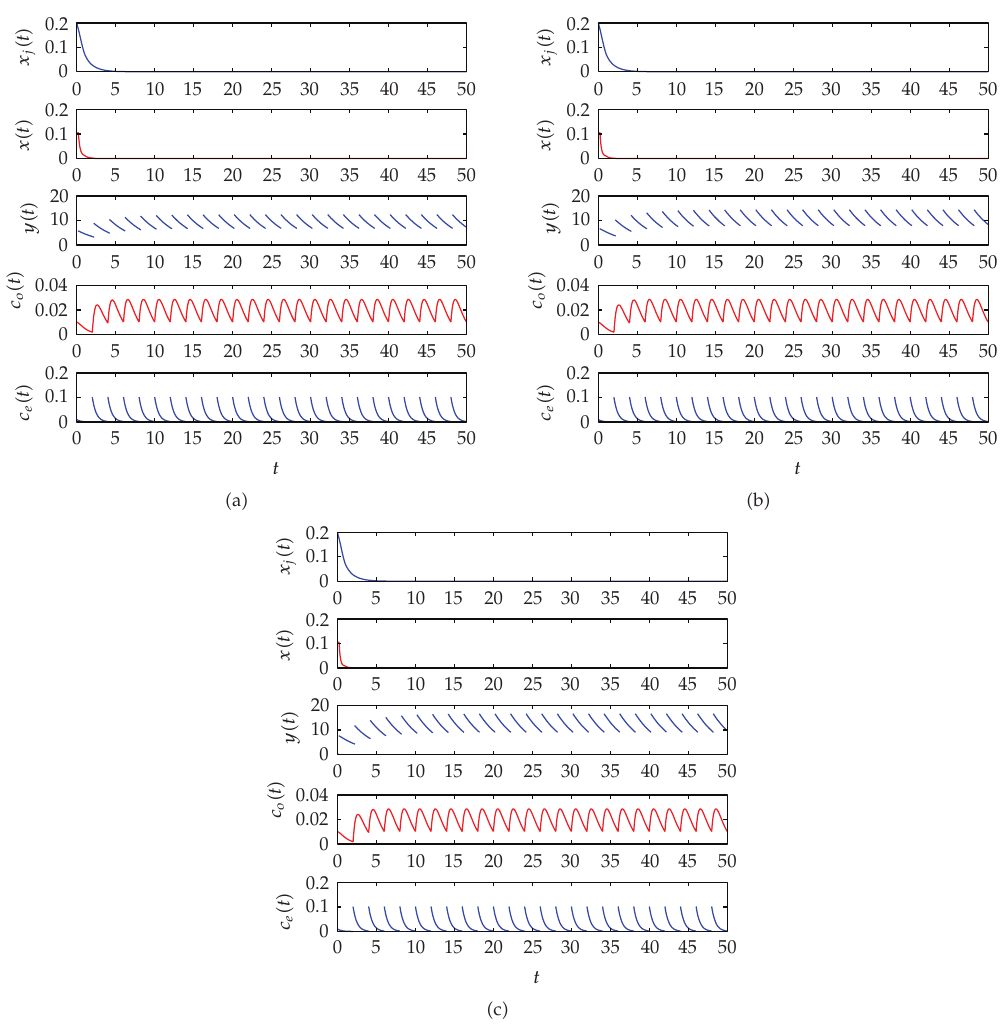
Figure 2: Dynamical behavior (cid:6) extinction (cid:7) of system (cid:6) 2.1 (cid:7) with a (cid:8) 0 . 8, b 1 (cid:8) 0 . 9, τ (cid:8) 0 . 7, f (cid:8) 0 . 2, β (cid:8) 0 . 9, η (cid:8) 1, r (cid:8) 0 . 7, b 2 (cid:8) 0 . 3, λ (cid:8) 0 . 9, k (cid:8) 1, g (cid:8) 0 . 5, m (cid:8) 0 . 7, h (cid:8) 2, l (cid:8) 0 . 1, T (cid:8) 2, μ 2 (cid:8) 0 . 1, initial values x j (cid:6) 0 (cid:7) (cid:8) 0 . 2, x (cid:6) 0 (cid:7) (cid:8) 0 . 1, y (cid:6) 0 (cid:7) (cid:8) 0 . 1, c o (cid:6) t (cid:7) (cid:8) 0 . 01, c e (cid:6) t (cid:7) (cid:8) 0 . 01 (cid:6) ∗ corresponding theoretical criteria value: μ ∗ Time-series of system (cid:6) 2.1 (cid:7) with μ 1 (cid:8) 5 . 6. (cid:6) b (cid:7) Time-series of system (cid:6) 2.1 (cid:7) with μ 1 (cid:8) 6 . 5. (cid:6) c (cid:7) Time-series of system (cid:6) 2.1 (cid:7) with μ 1 (cid:8) 7 . 5.